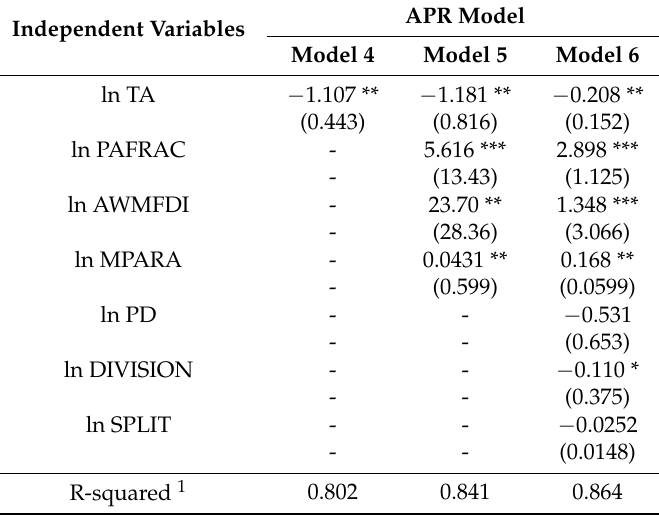
Table 8. Estimation results for APR model.